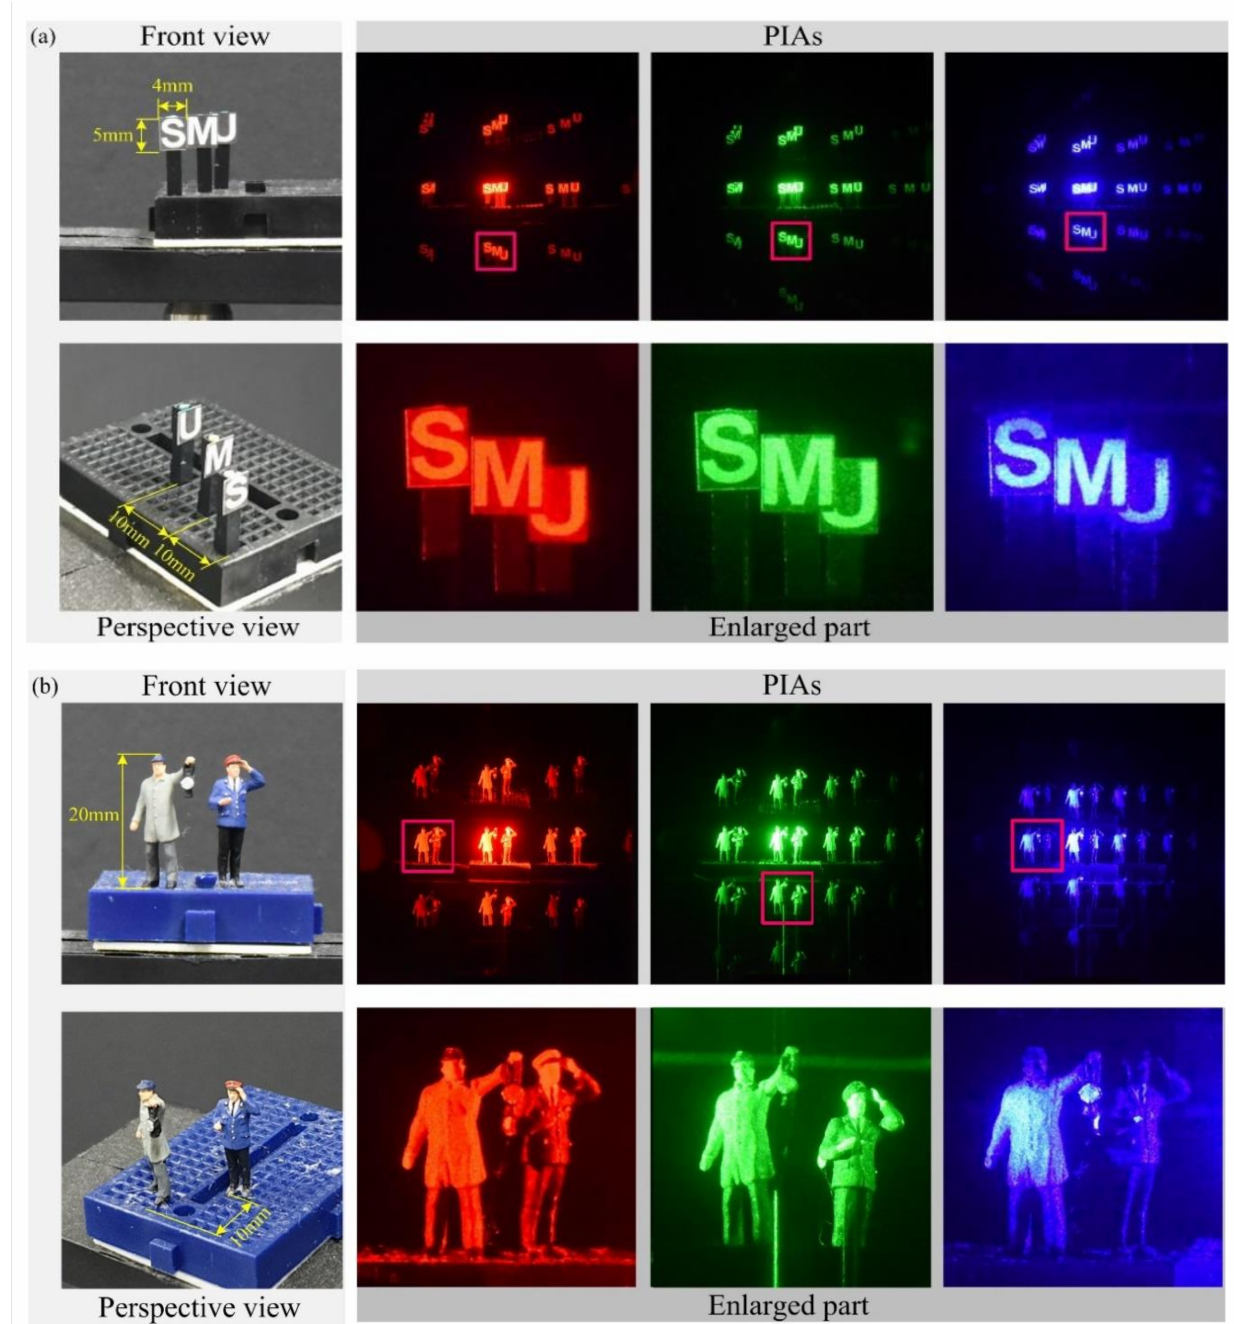
Figure 9. Objects used in our optical experiments and their PIAs and examples of a parallax image of the first-order diffraction in each PIA for ( a ) three flat objects of ‘S’, ‘M’, and ‘U’ and ( b ) two human miniatures. See the text for the discussion on the captured